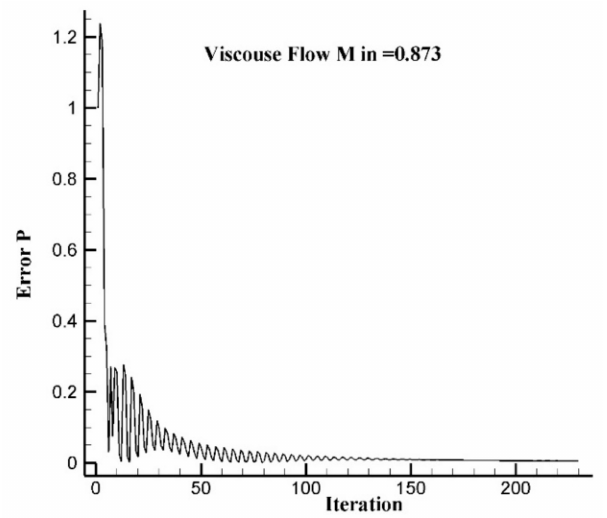
Figure 5. Convergence of residuals of pressure differences through the geometry corrections in the validation of original UESA at AOA = 1 ◦ (Mach inlet = 0.87).